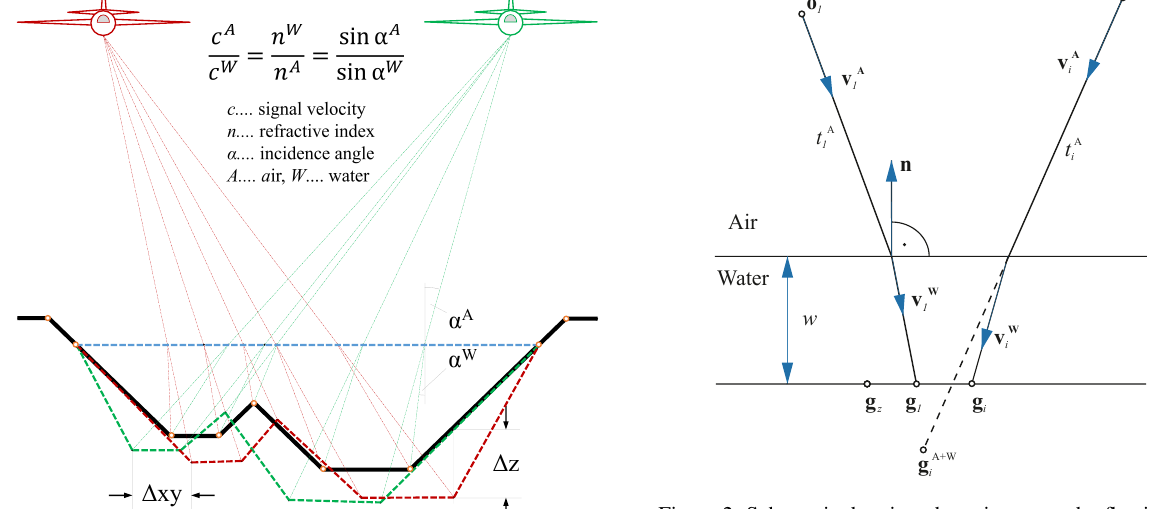
Figure 2. Schematic drawing observing ground reflections in constant water depth w from two different viewing directions. The point g A+W is the point without refraction i